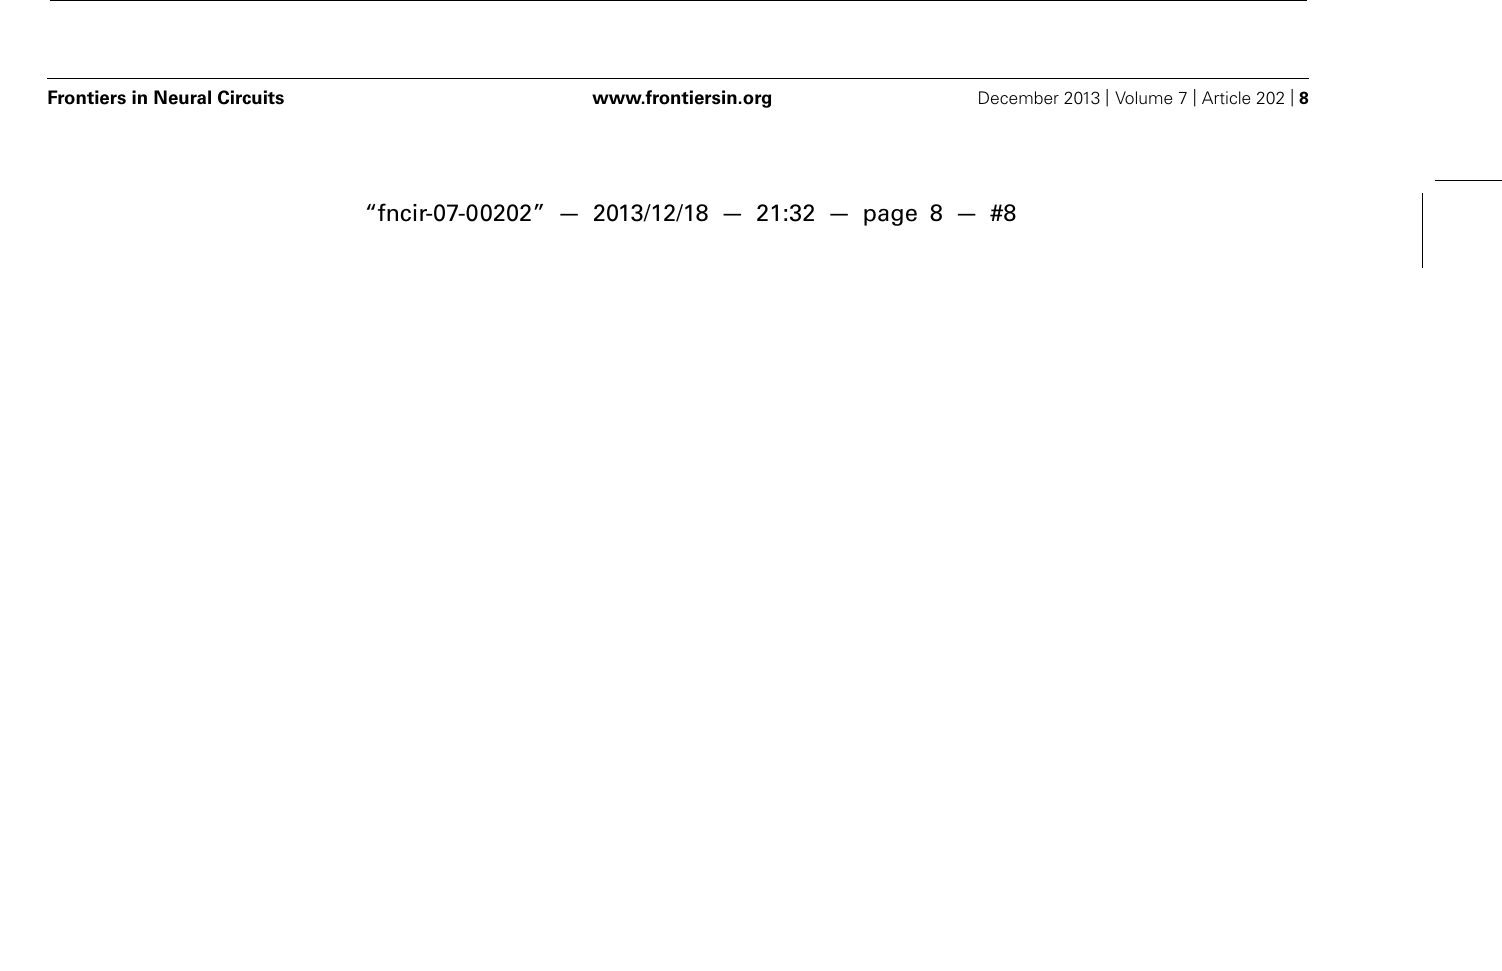
FIGURE 4 | Clathrin-mediated endocytosis of synaptic vesicle membrane is reduced in synapses even when mRFP-AP180C content is low . (A) Change in SypHy fluorescence intensity (normalized to the peak) after 40